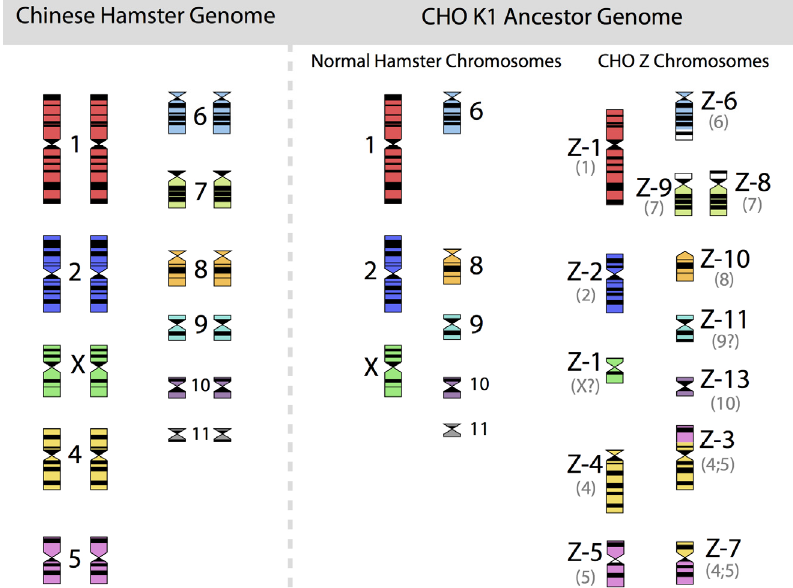
Figure 2. The 22 chromosomes of the Chinese hamster and of the 21 chromosomes of CHO-K1 as identified by G-banding techniques. Redrawn by C.P. Wurm after the publication of Deaven and Peterson (1973) [31]. Part of this figure was first published in Nature Biotechnology, 2011